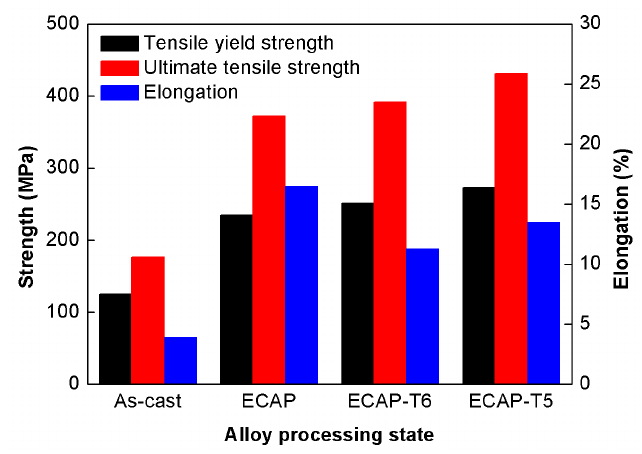
Figure 10. Tensile properties of Mg-10Y-6Gd-1.5Zn-0.5Zr alloys at different processing states.